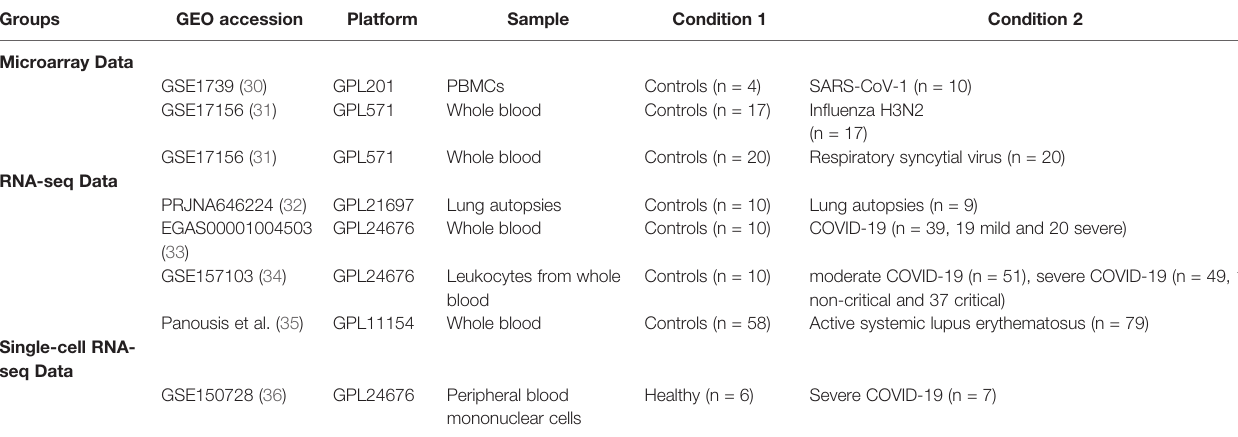
TABLE 2 | Gene expression datasets used in this